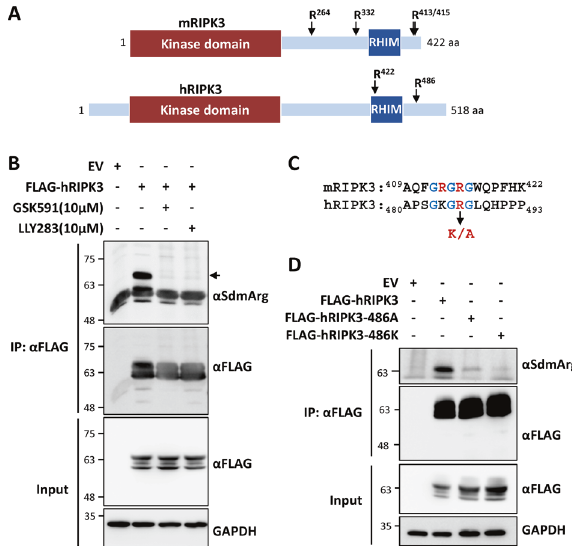
Fig. 3 Identi fi cation of conserved arginine methylation sites on RIPK3. A Schematic representation of human and mouse RIPK3 proteins with domain organization and arginine (R) methylation sites. B Human RIPK3 is a substrate of PRMT5-mediated symmetric arginine methylation (inhibitor treatment: last 6 h before cell lysis). C Alignment of mRIPK3 and hRIPK3 sequences reveal R486 in hRIPK3 (R415 in mRIPK3) as the only evolutionarily conserved methylation site. K/A denotes mutagenesis of the site to lysine (K) and alanine (A) residues to generate methylation-de fi cient mutants. D Mutagenesis of R486 residue (R486K or R486A) abrogates symmetric arginine dimethylation of hRIPK3 as shown by FLAG-IP enrichment and analysis with SdmArg